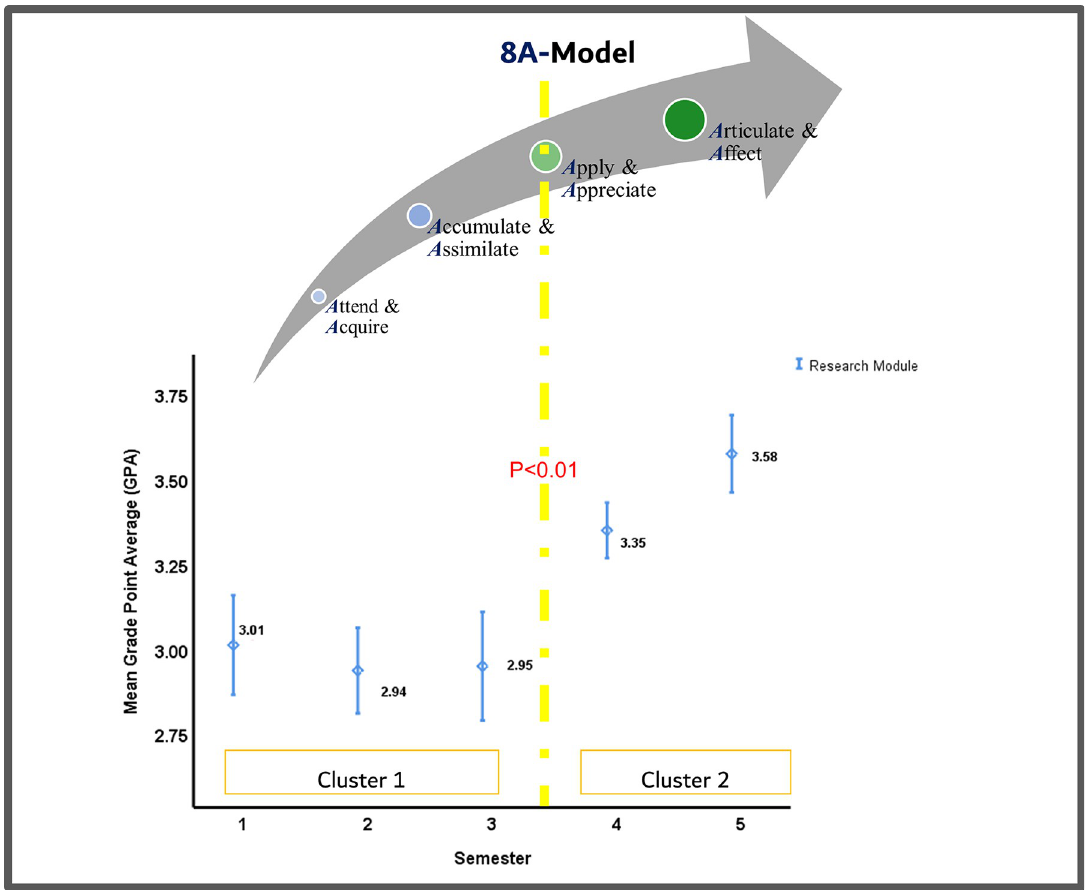
Fig 3. A joint display, mapping the qualitative findings (the study’s conceptual framework) with the quantitative analysis (dispersion of cluster-level performance measure) in the 5-integrated research courses across 5 consecutive semesters (semesters 1, 2, and 3 where students were ‘taught about research’ and semesters 4 and 5 where students were ‘enabled to conduct research’). Mapping the study’s conceptual framework onto the student’s performance revealed a holistic perspective of the situation. The convergence of findings, as such, confirmed the existence of a turning point (highlighted with a Yellow dotted line). The students started expressing appreciation of the value of the learning experience upon putting into practice the knowledge and skills that they were acquiring, accumulating, and assimilating. The color transformation [ie from a primary color (ie Blue) to a secondary color (ie Green: Blue + Yellow)] further emphasizes this turning point, and how the increased appreciation happened concurrently with their increased engagement and enhanced